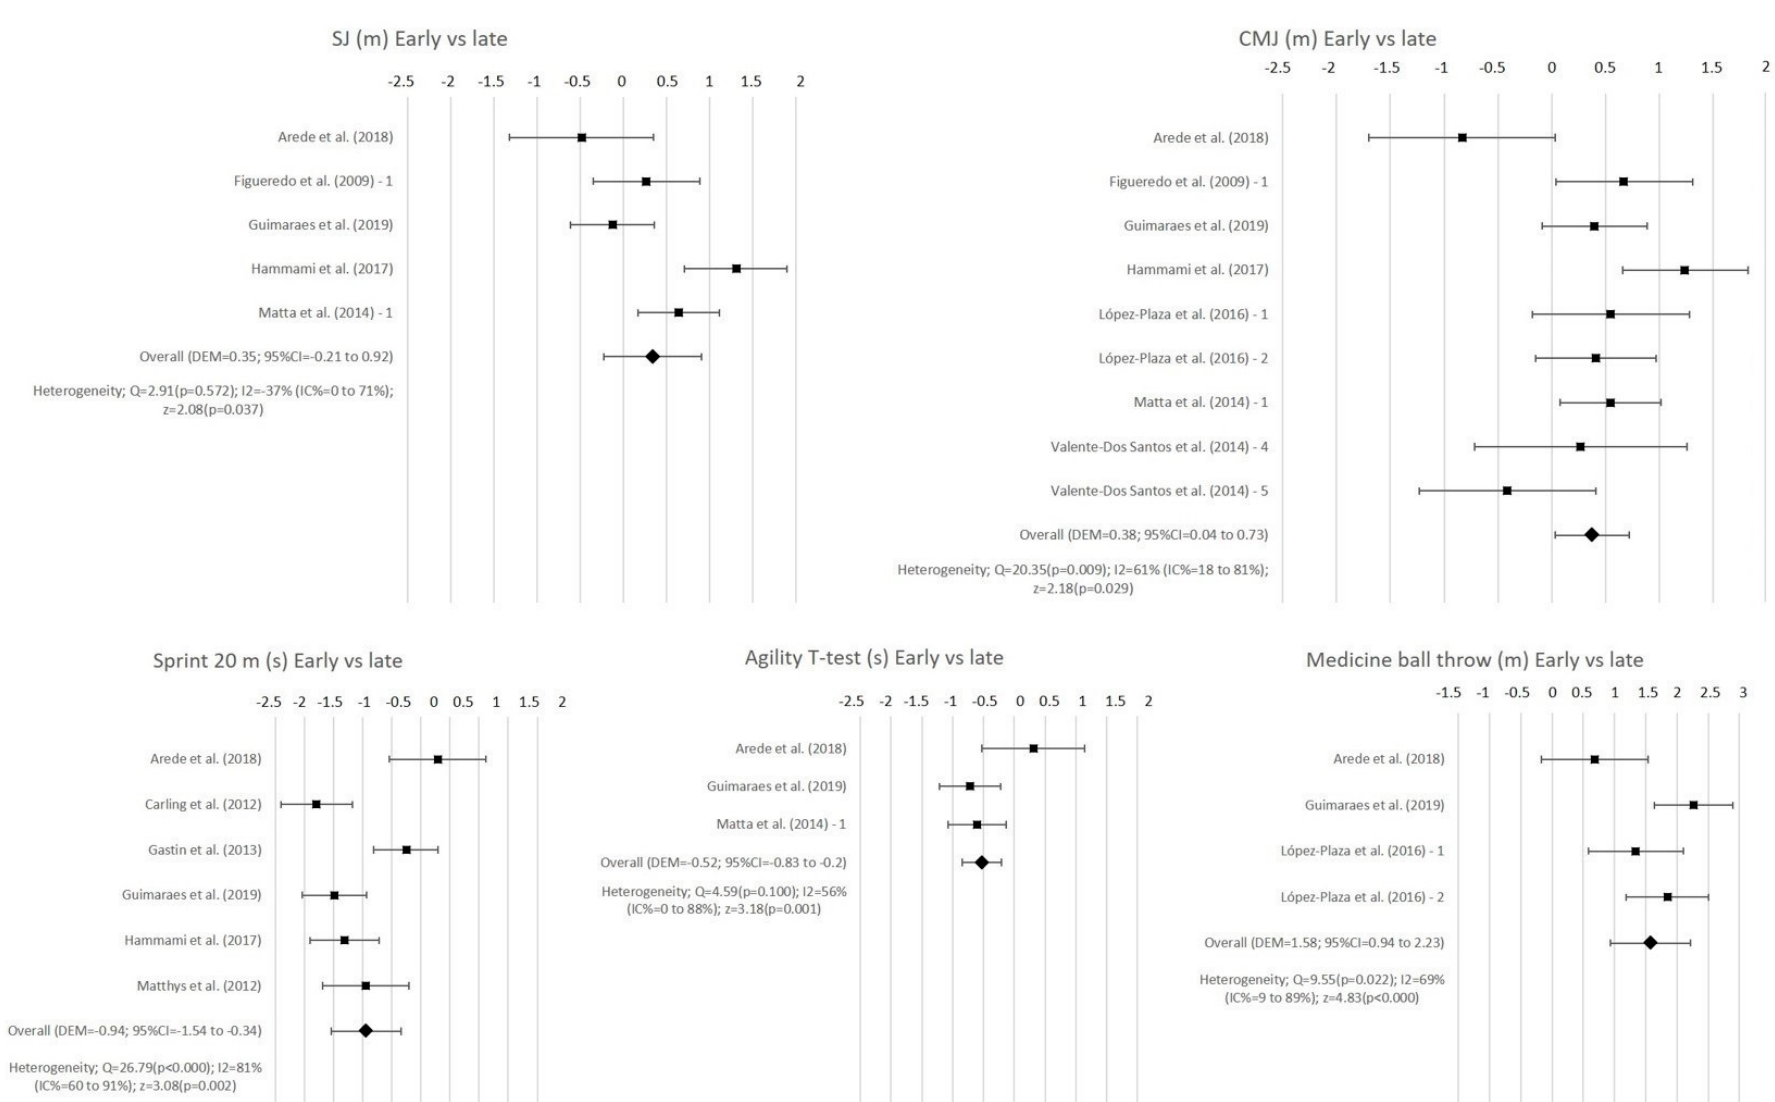
Figure 2. Forest plot of early and late maturation for physical fitness